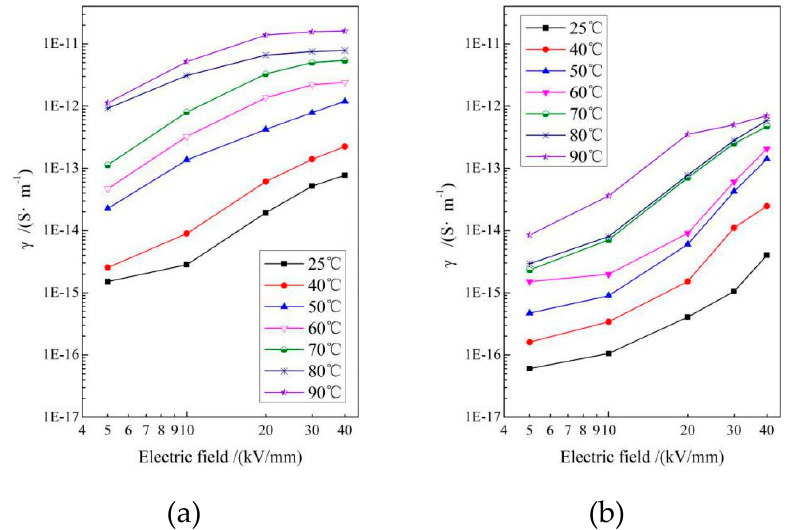
Figure 6. γ - E curves of ( a ) LLDPE and ( b ) UV-XLPE-TMPTMA at various temperatures of 25–90